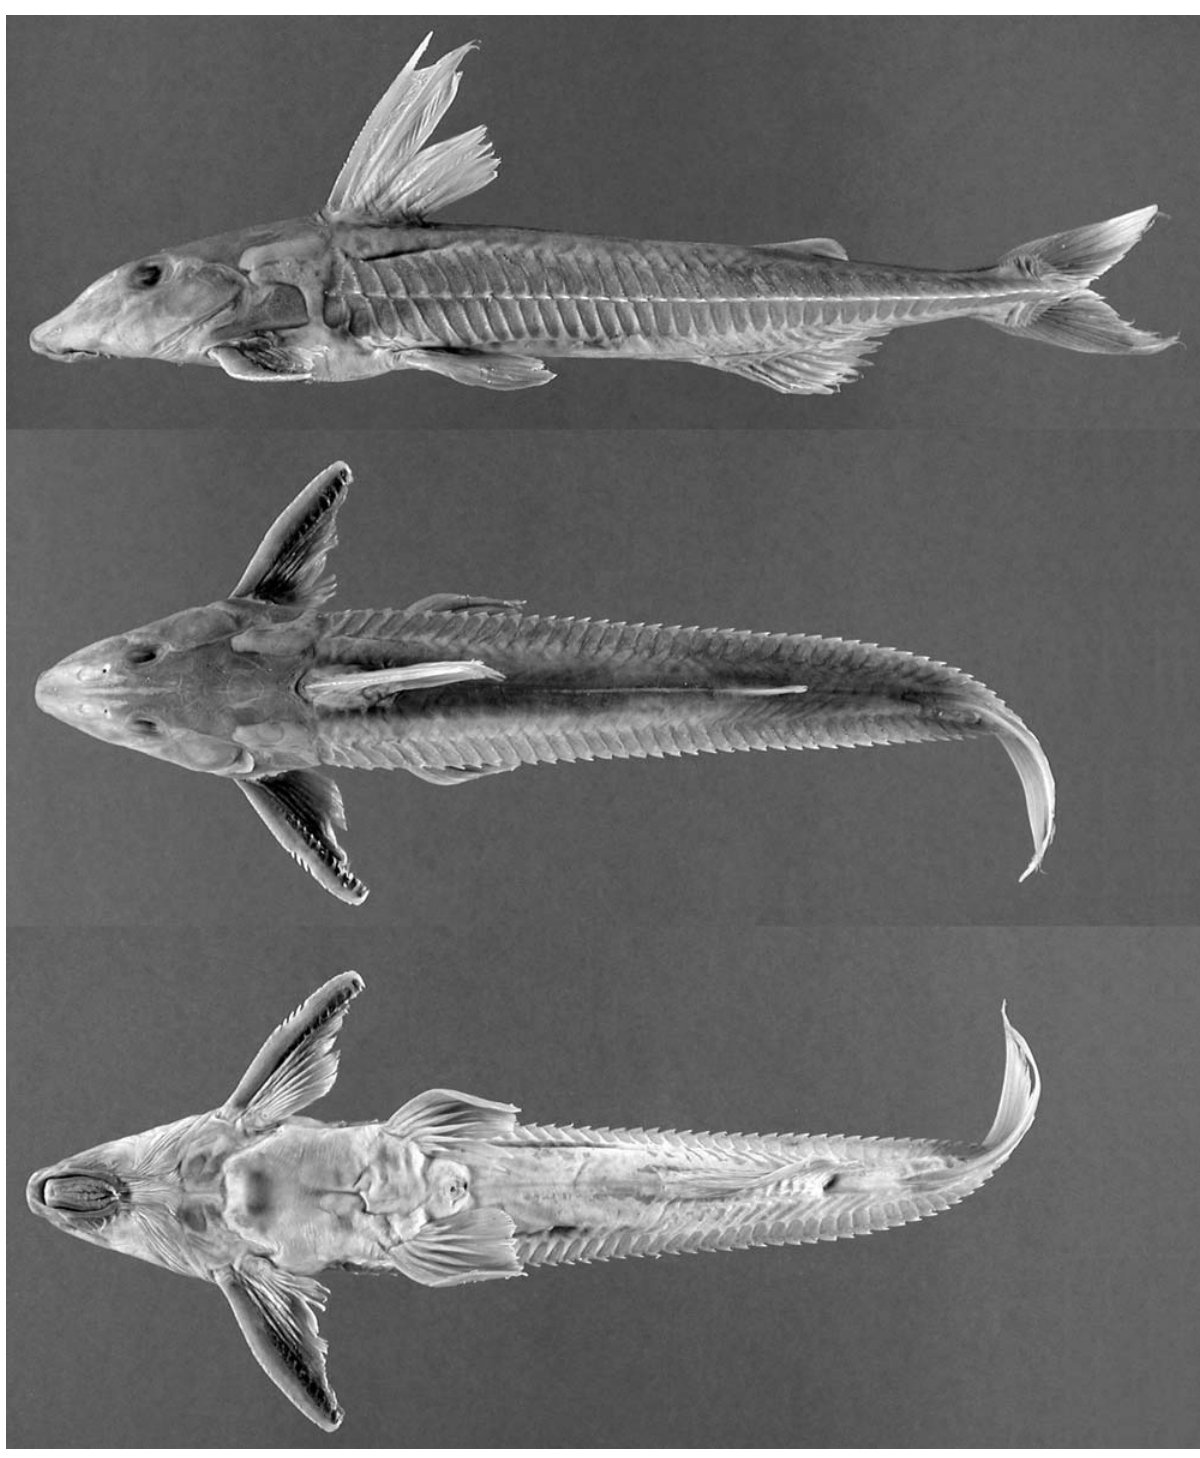
Fig. 17. Leptodoras acipenserinus , FMNH 92385 (SL 196.5 mm), río Bobonaza (Pastaza–Marañon dr.),